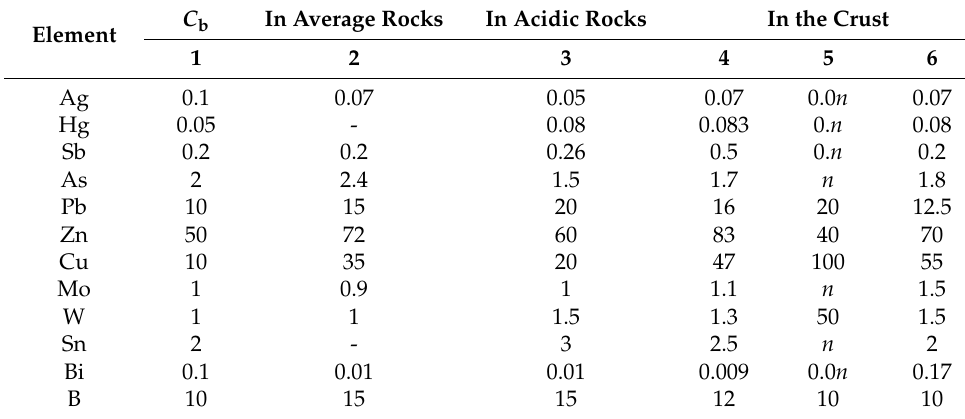
Table 1. Average element contents